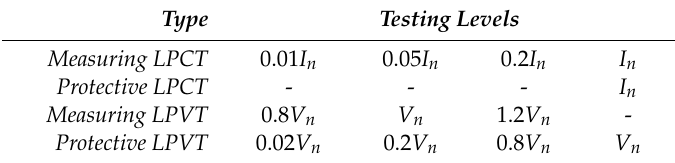
Table 2. Testing levels, taken from IEC 61869-10, 11, for LPCTs and LPVTs, respectively.